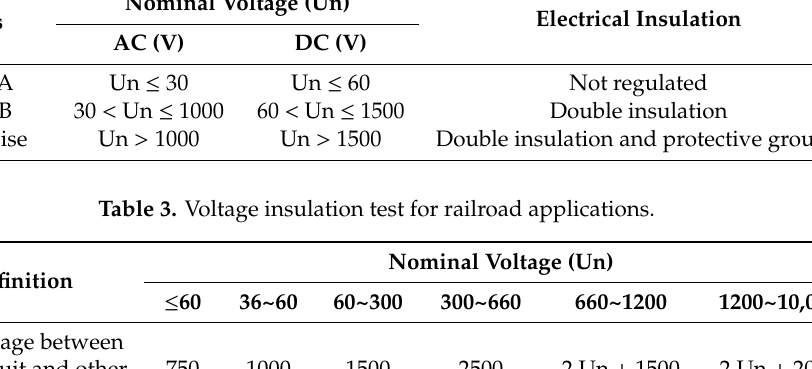
Table 2. Specifications for the propulsion system of fuel-cell powered railroad vehicle.